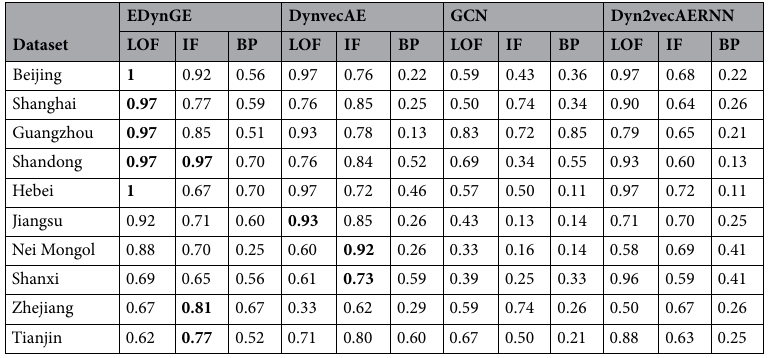
Table 2. Comparison results on real-world meteorological datasets (the bold scores indicate the best performance with the given datasets).